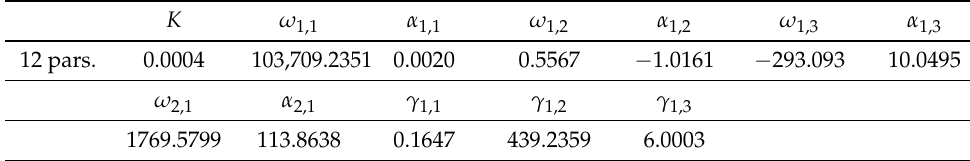
Table 3. Parameters of the fitted 12-parameter real-order